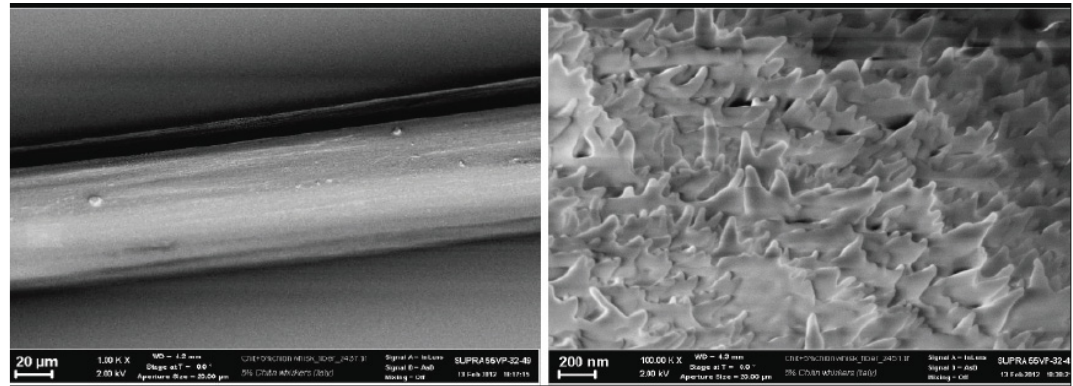
Figure 19. The smooth surface of chitosan/CN composite fiber ( a ) shows a regular disposition of CN into its inner structure ( b ). The fiber contains 1 wt% of CN.